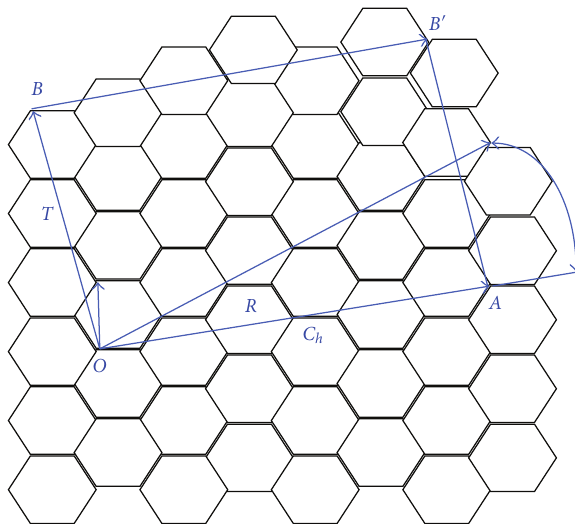
Figure 1: The periodic lattice of graphene consisting of the unit cell of two carbon atoms.